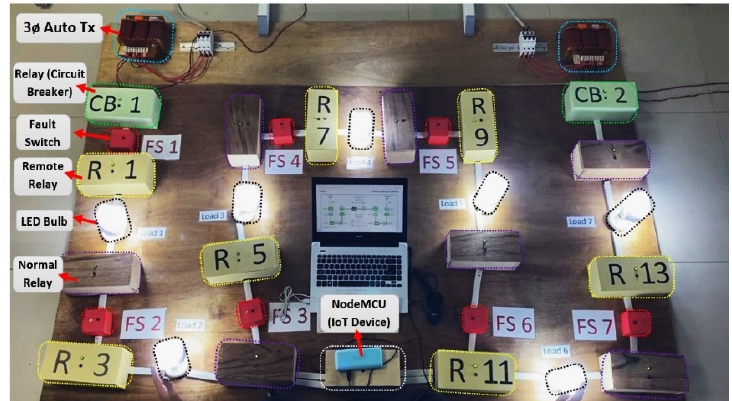
Figure 6. Hardware setup.